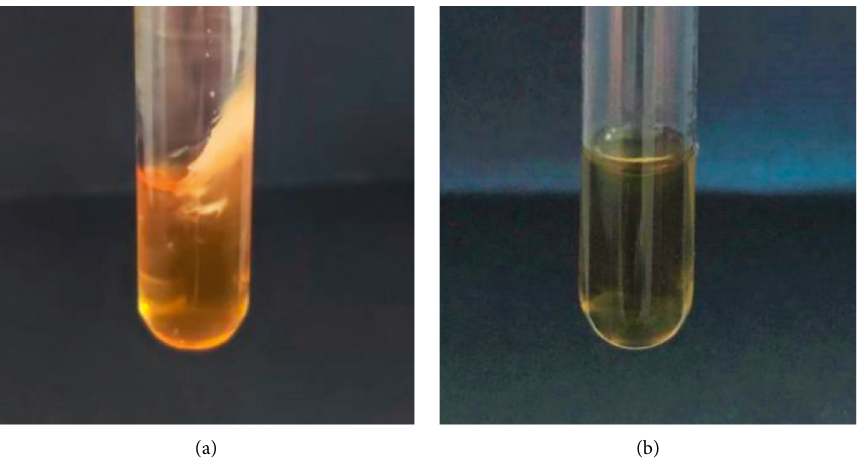
Figure 3: 5ml TB tubes in (a) without sterilization and in (b) after sterilization with 25 kGy of gamma rays.